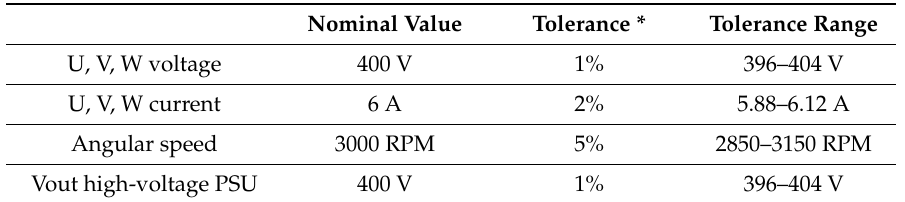
Table 1. The nominal values and tolerances defined in the system design phase (* defined by the complex system designer).